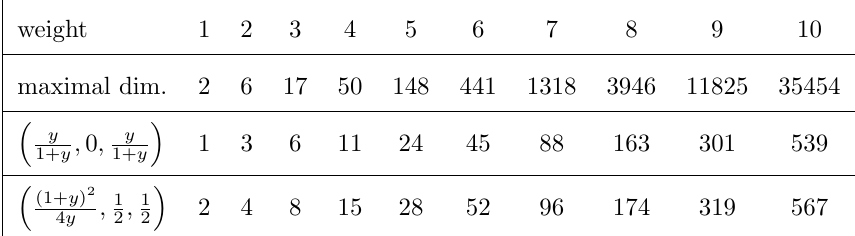
Table 16 . Dimensions of H hex when restricted to the two lines with with symbol letters y; 1 (cid:0) y; 1+ y . The maximal dimension corresponds to allowing all alternating sums and all HPLs with no branch cuts except at u = 0 ; 1 . We only count the (cid:12)nite parts of the functions on the (cid:12)rst, singular